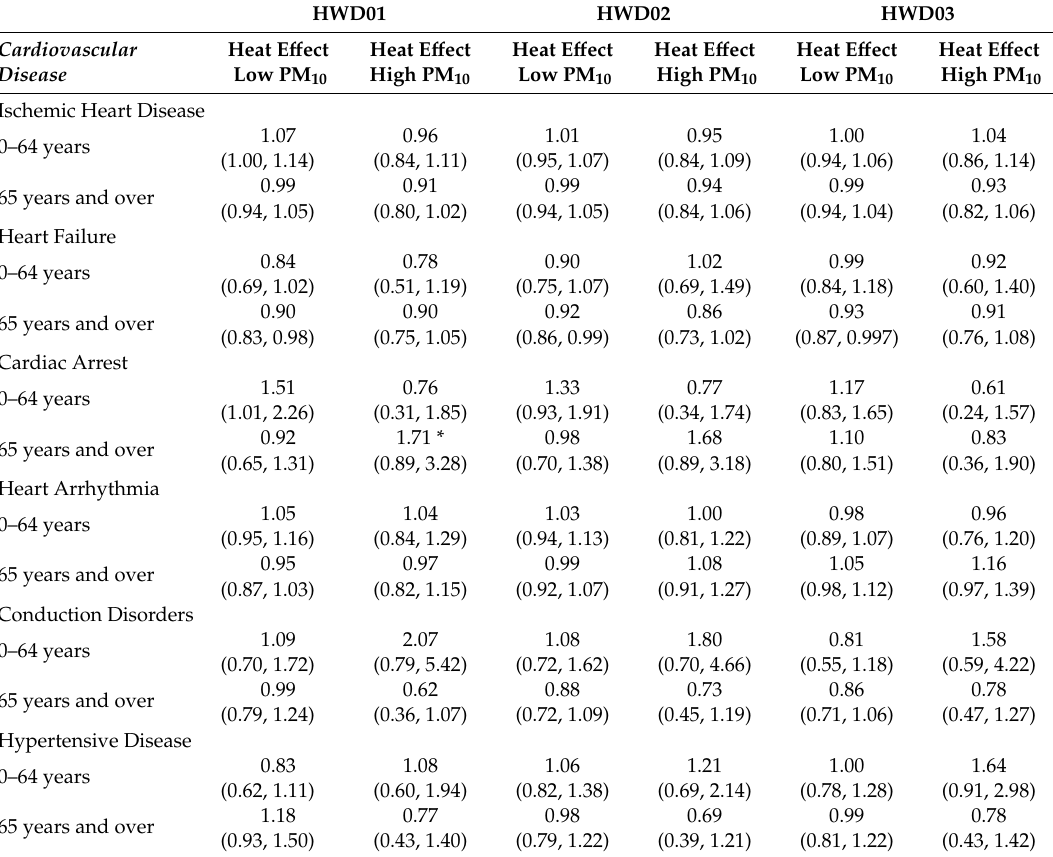
Table A2. The e ff ect of heat wave days on EHAs for cardiovascular diseases on days with high levels of PM 10 compared to days with low levels of PM 10 in the SSD during the warm season, 2001 to 2013, for those aged 0–64 years and 65 years and over at lag 2